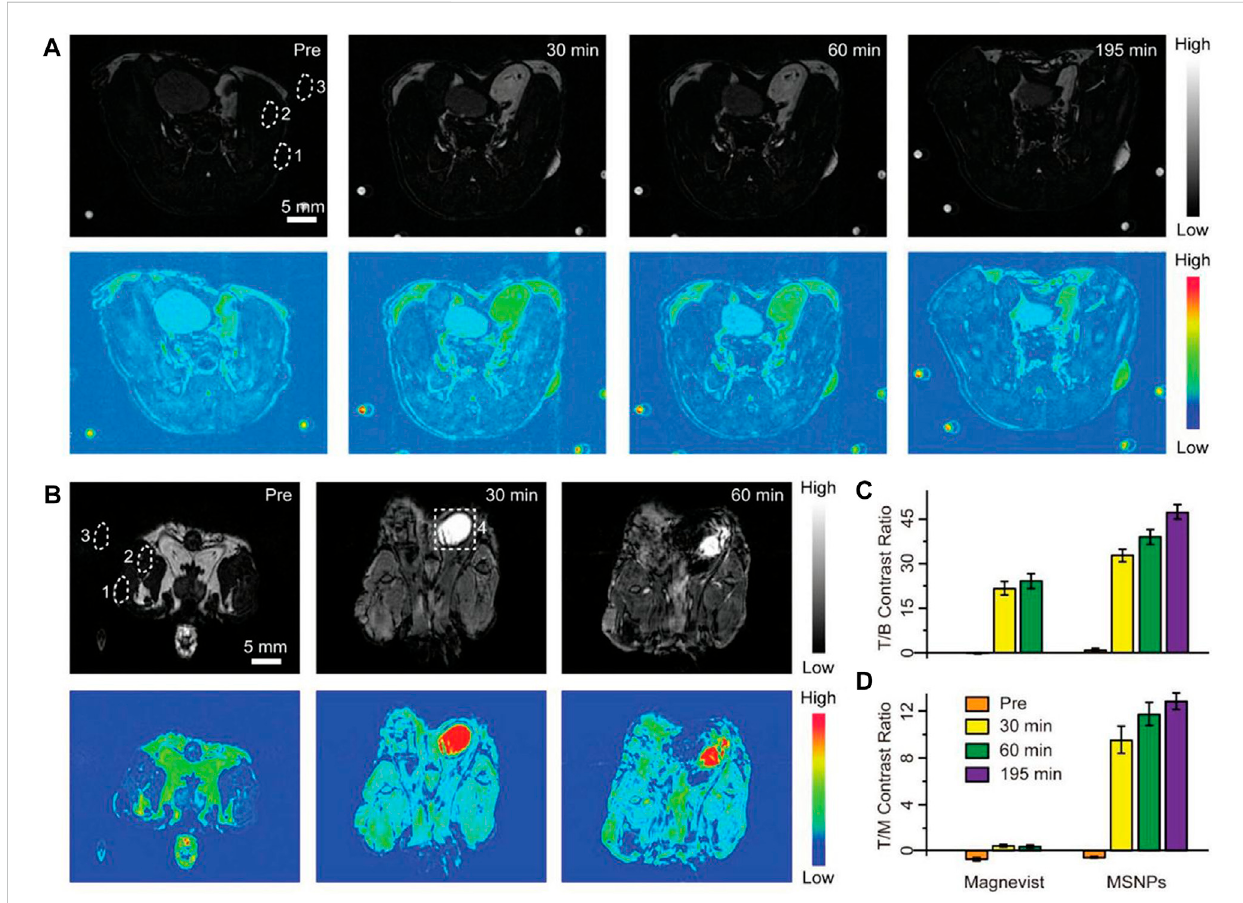
Positive contrast enhancement evaluation in vivo . (A, B) T1-weighted MRI and corresponding pseudocolor images of tumor-bearing mice after intravenous injection of cell membrane coated-BSNPs (MSNPs) (A) and Magnevist (B) with the same dosage (2.5 μ mol of Gd 3+ for each mouse). Images were captured before and at different time points after the administration of contrast agents. The time points were collected at the midpoint of the time interval during each imaging acquisition. The dotted circles represent the regions of interest: 1) tumor, 2) muscle, 3) background, and 4) bladder. Scalebarsare5 mmforallimages.ThesmallspotsonthecornersarefromthecirculationapparatusintheMRIscanner. (C,D) Tumor-to-background(T/ B) and tumor-to-muscle (T/M) contrast ratios based on the corresponding MRI images. Values represented as means ± s.d. ( n = 3). [Reprinted with permission from Ref. (Yi et al., 2019) Copyright 2019: John Wiley & Sons,